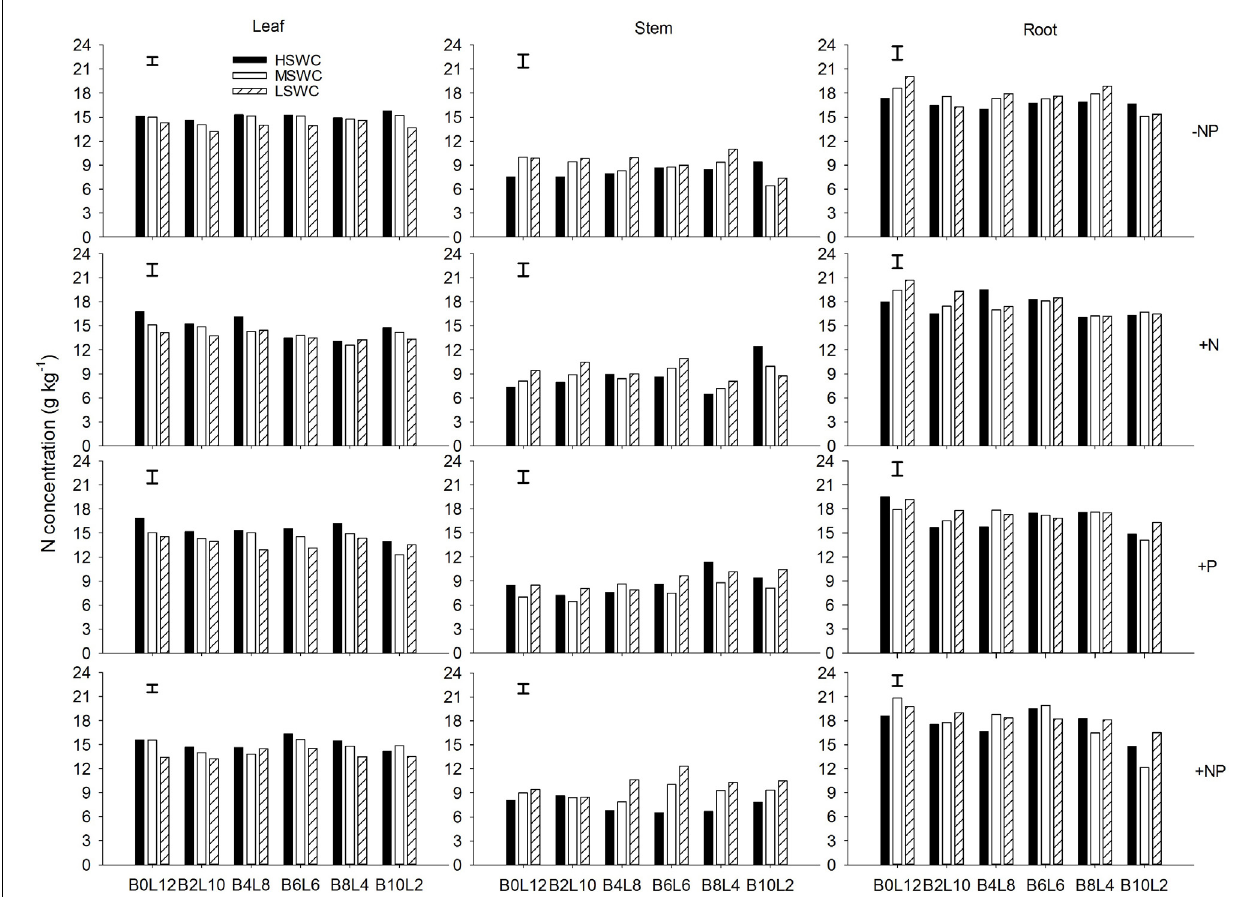
FIGURE 1 | Leaf, stem, and root N concentration of Lespedeza davurica (L) mixed with Bothriochloa ischaemum (B) at various mixture proportions under three soil water regimes [HSWC: 80% FC (field capacity); MSWC: 60% FC; LSWC: 40% FC] and four fertilization treatments (–NP, +N, +P, +NP). B i L j ( i , j = 0, 2, 4, 6, 8, 10, 12; i + j = 12) means the plant numbers of B. ischaemum to L. davurica in their mixtures. Error bars are LSD ( p < 0.05).